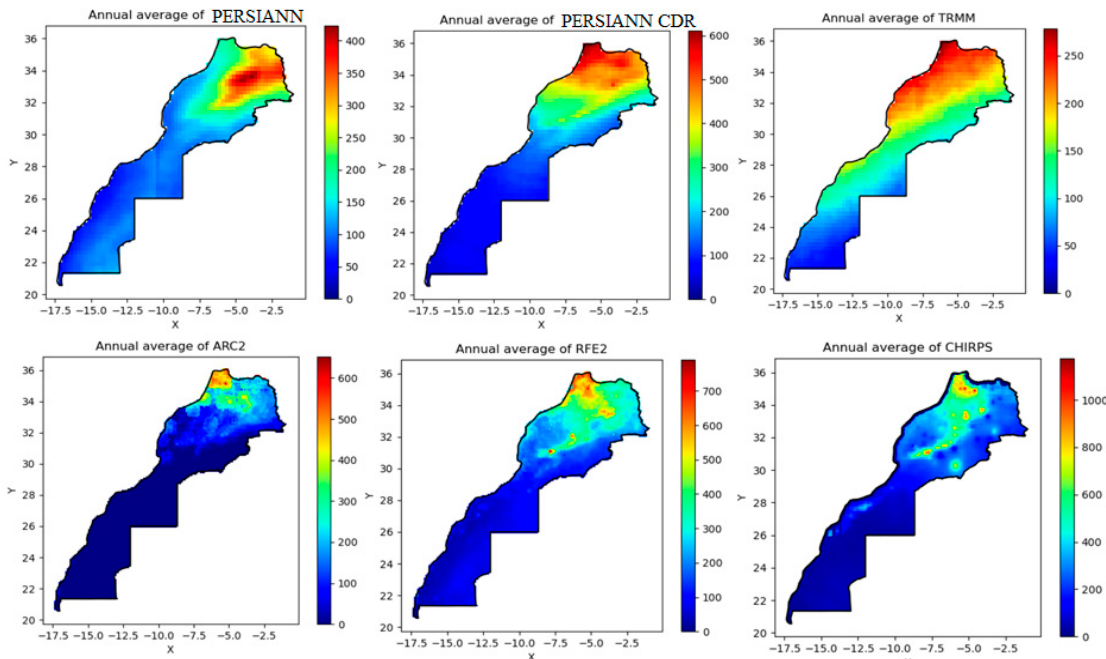
Figure 1. Simulated satellite-based average annual rainfall for the study period. (x: longitude, y: latitude).